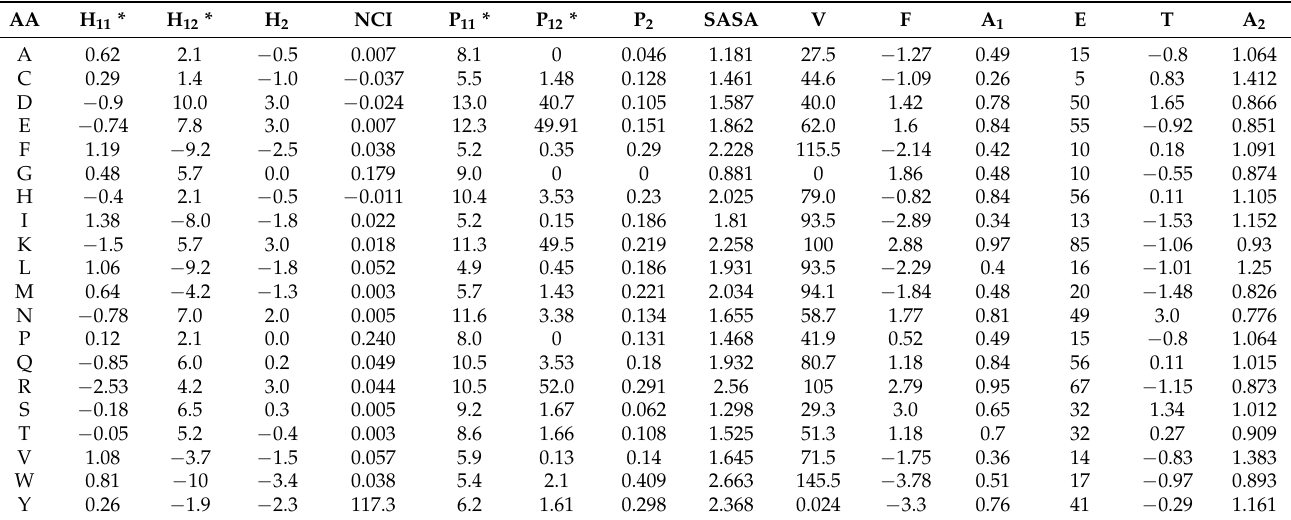
Table 5. Values of the 12 physicochemical property scales of the 20 essential amino